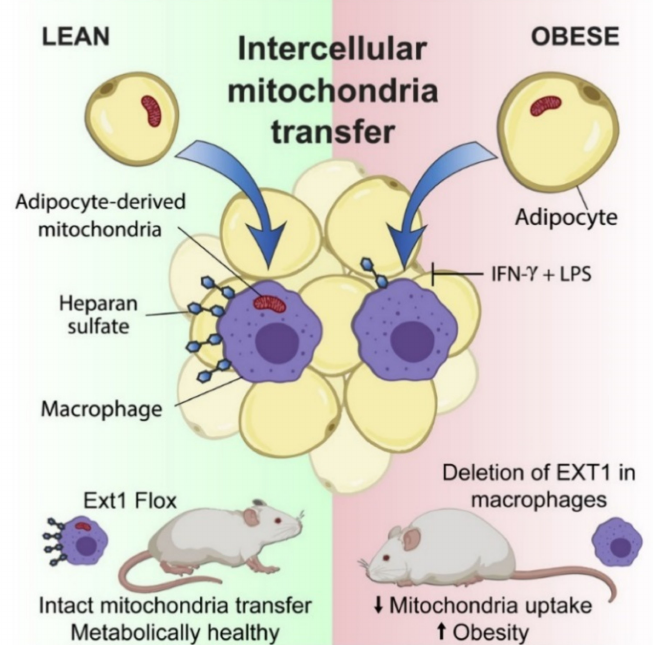
Figure 3. Intercellular mitochondrial transfer from adipocytes to macrophages. WAT-resident macrophages take up mitochondria from neighboring adipocytes in a heparan sulfate-dependent process that is impaired in obesity. Genetic disruption of mitochondria uptake by macrophages reduces energy expenditure and aggravates diet-induced obesity in mice, indicating that intercel- lular mitochondria transfer to macrophages promotes systemic metabolic homeostasis. Illustration from